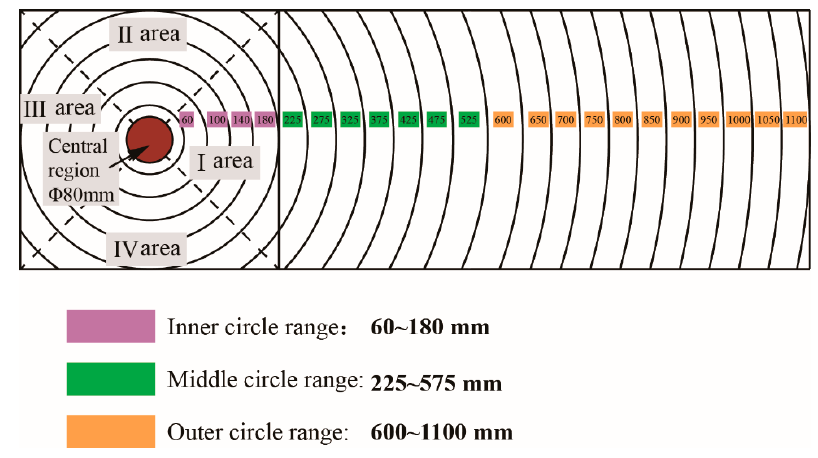
Figure 7. Division of the spatial distribution of fragments.